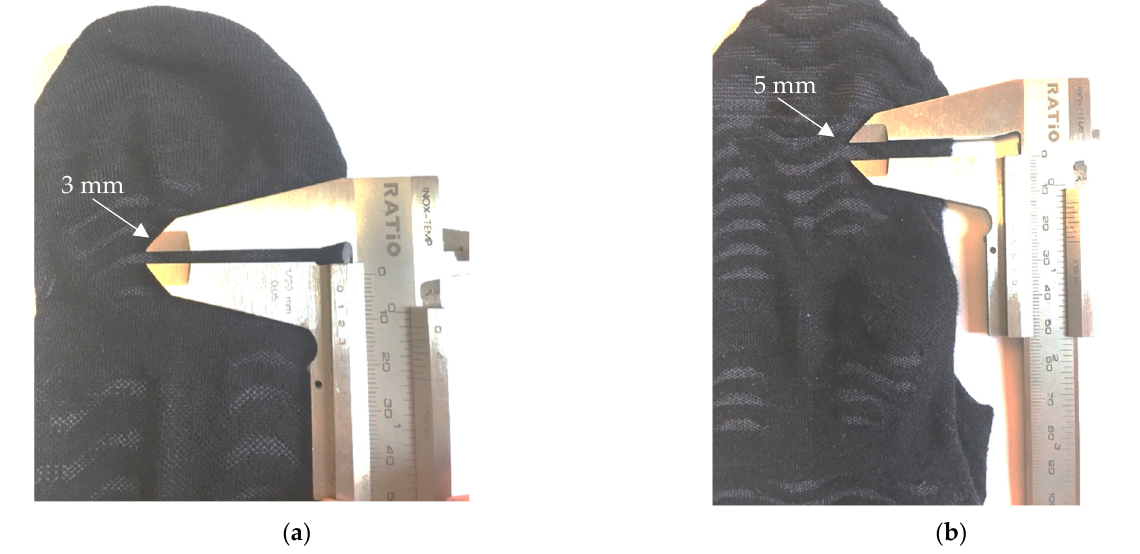
Figure 1. Configuration of plantar ribbing in sock models AWC 1, 3 mm ( a ) and AWC 2, 5 mm ( b ).